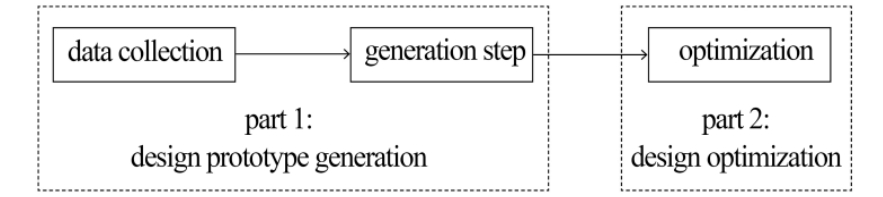
Figure 5. Basic steps of design generation and optimization.